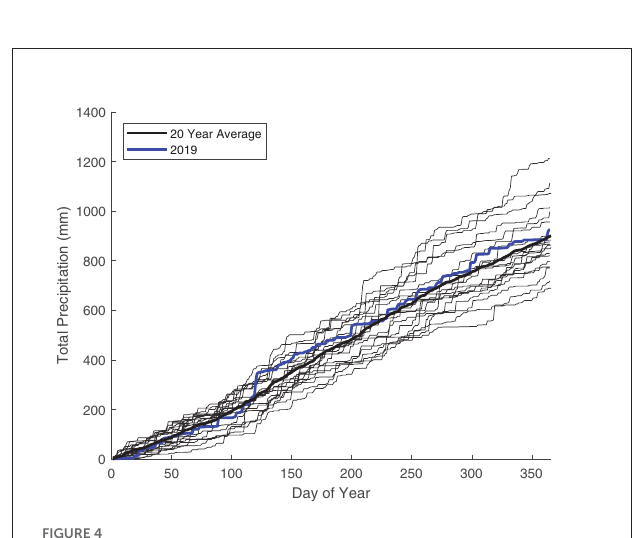
FIGURE4 Cumulative precipitation for the 20-year period (2000–2019; black lines) with the 2019 precipitation (thick blue line) for Detroit. The 20-year mean is presented with a thick black line.